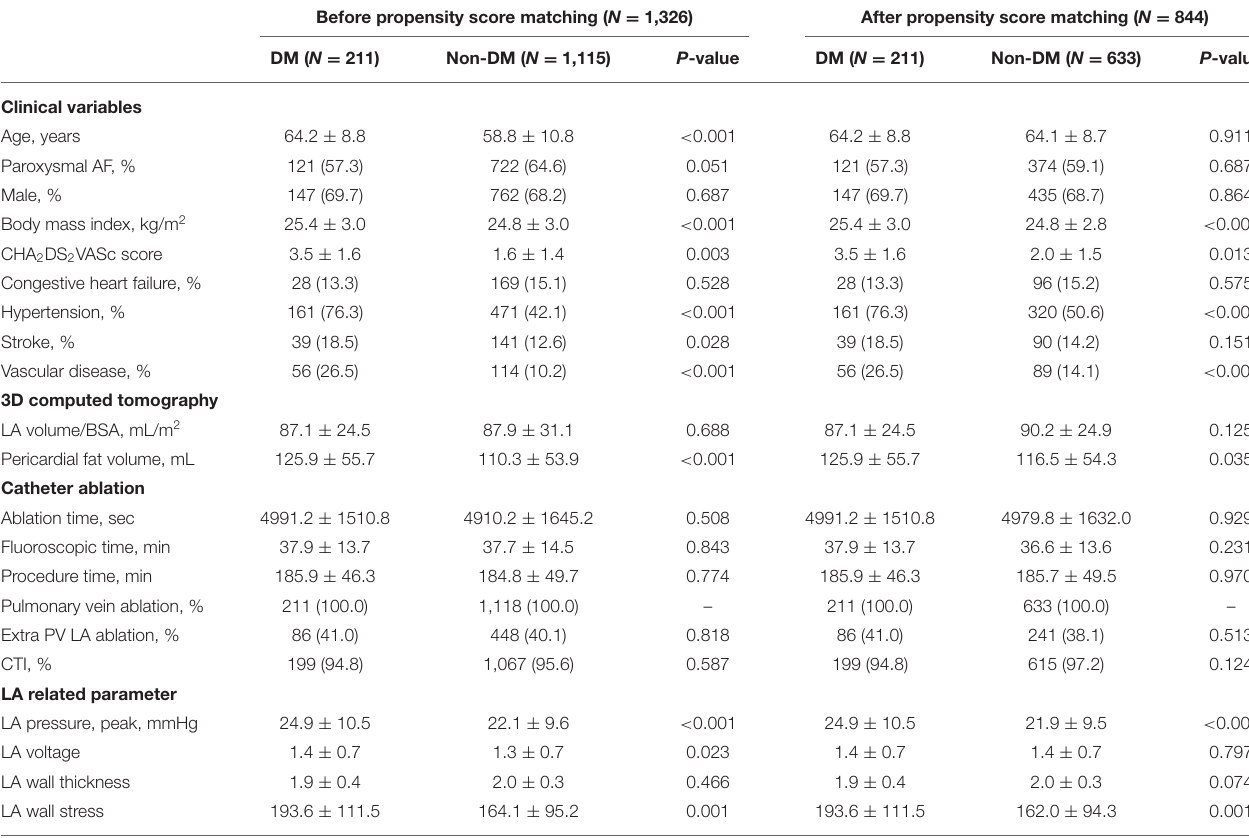
TABLE 1 | Baseline characteristics according to the presence of DM. Before propensity score matching ( N = 1,326) After propensity score matching ( N = 844) DM ( N = 211) Non-DM ( N = 1,115) P -value DM ( N = 211) Non-DM ( N = 633) P